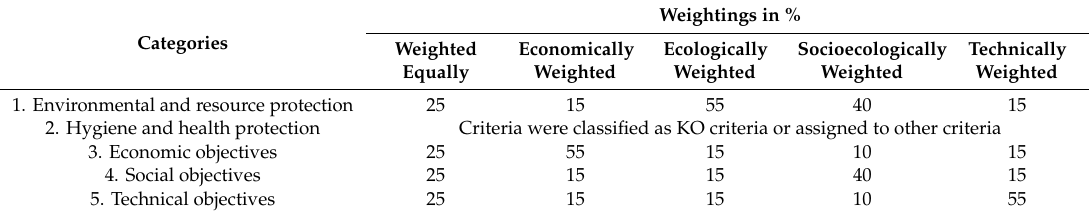
Table 2. Options for weighting of categories in the DWA-A 272 scheme according to [42].